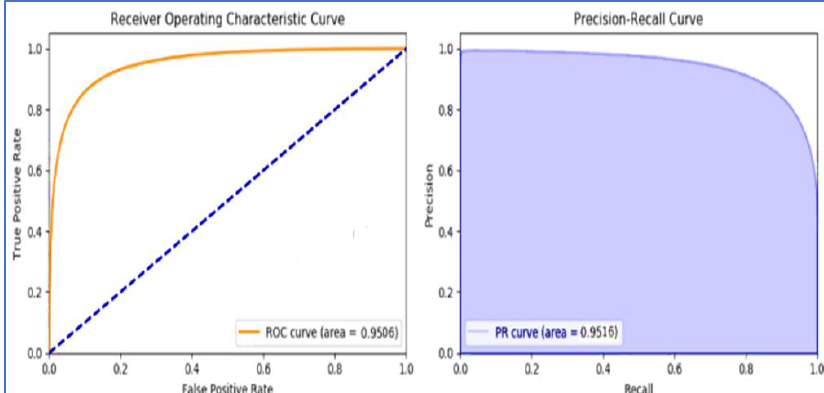
Figure 15. Gradient Boosting Tree Classifiers ROC.